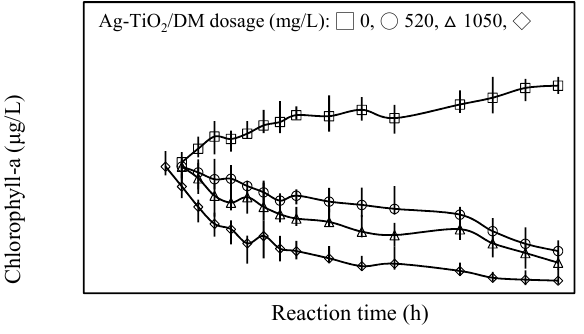
Figure 2. The concentrations of chlorophyll-a as a function of photocatalytic reaction time in Microcystis aeruginosa suspensions.